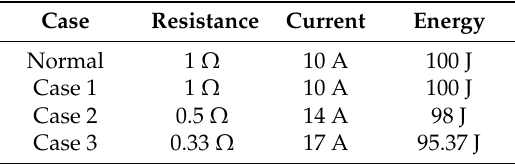
Table 7. Internal heat of cable.